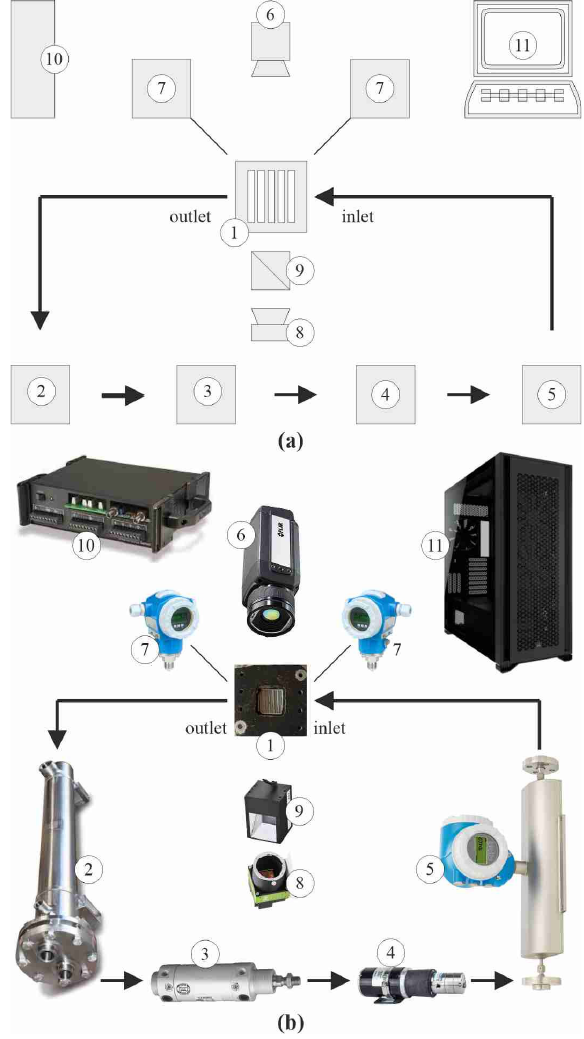
Figure 1. The schematic diagrams of the experimental stand: ( a ) a block diagram, ( b ) a pictorial diagram; 1—test section with a mini-channel heat sink, 2—heat exchanger, 3—compensating tank,